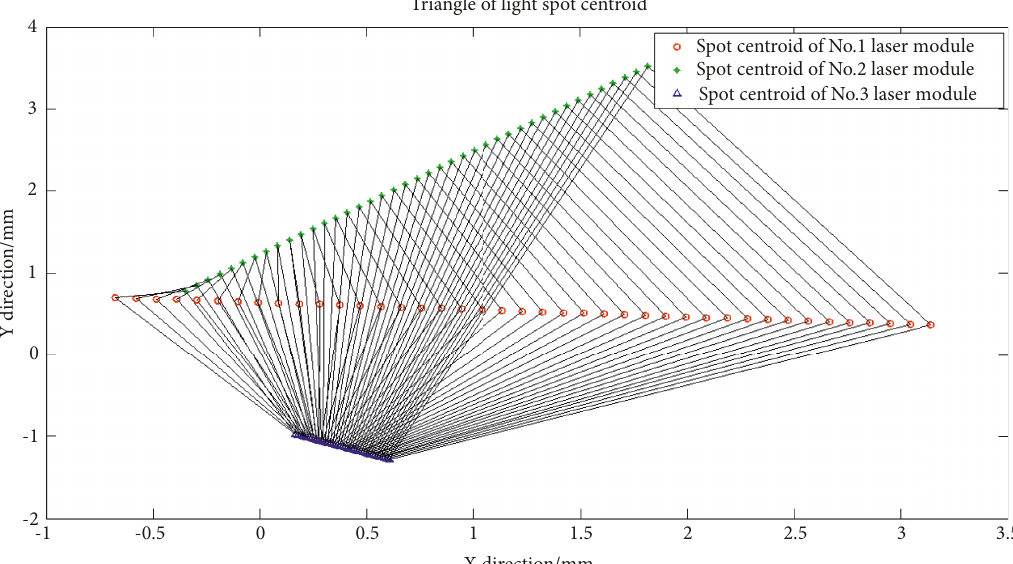
Figure 12: Forty-one sets of experimental data of three-dimensional coordinates of the spot centroid obtained by the PSD.